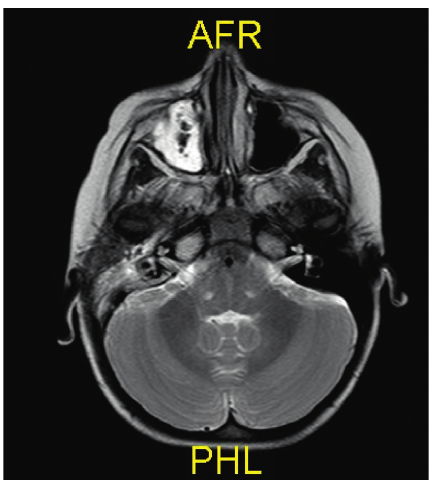
Figure 1: Effusion in right mastoid cells and marked mucosal thickening in the right maxillary